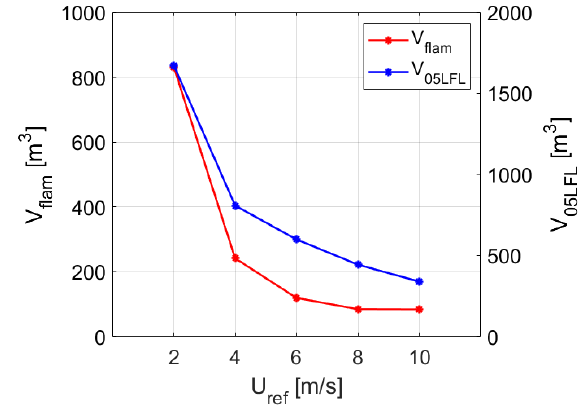
Figure 15. V flam and V 05LFL as a function of U ref .